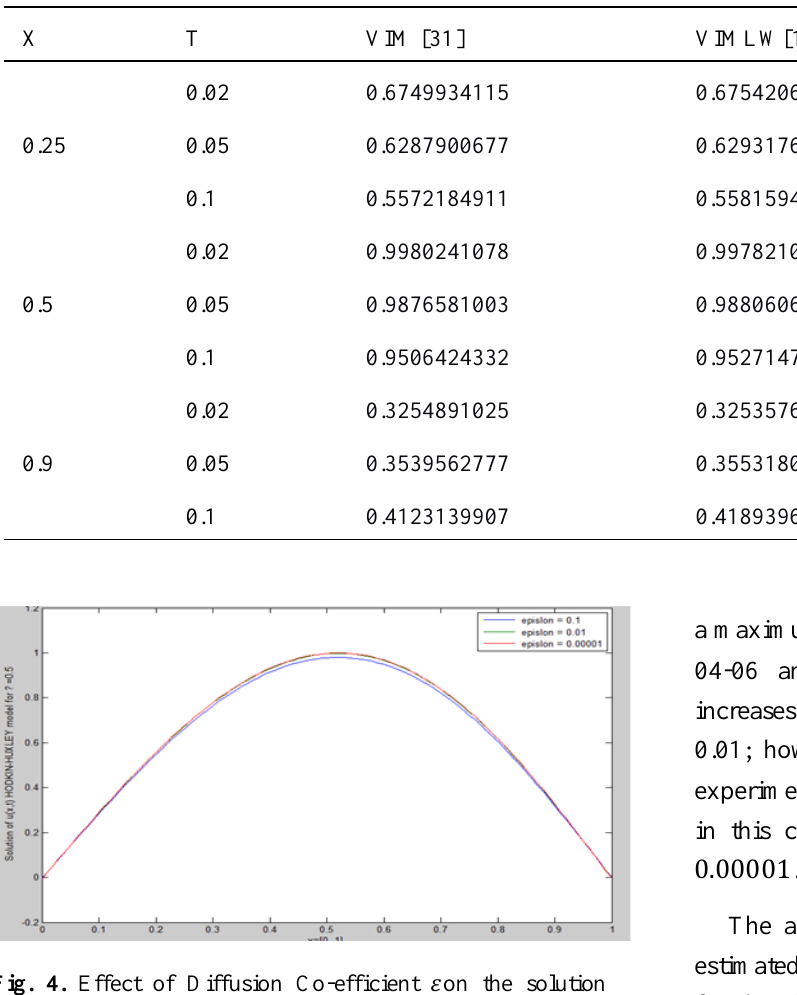
Analysis of the computed solution with different parameters, when 𝛼 = 𝛽 = 𝛾 = 1 and for 𝜀 = 0.00001